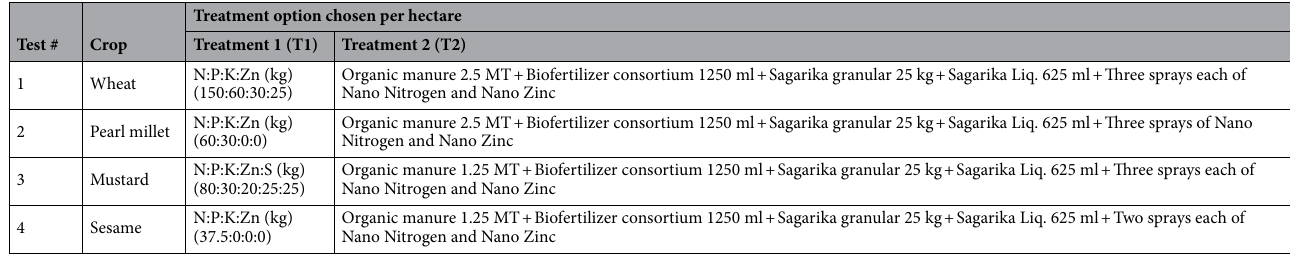
Table 2. Tested crops and treatment details. Base fertilizer of N, P, K, S, Zn, Sagrika were obtained from Indian Farmers Fertilizer Cooperative Limited. Nano fertilizers of N, Zn and Cu were used at the rate of 2.5 ml/l. Organic manure (i.e. farm yard manure) with a typical composition of 0.5% nitrogen, 0.2% phosphorus and 0.5% potassium. N nitrogen as ammonia or nitrate, P phosphorus as P 2 O 5 , K potassium as K + , Zn zinc as zinc sulphate, S sulphur as SO 4 2−